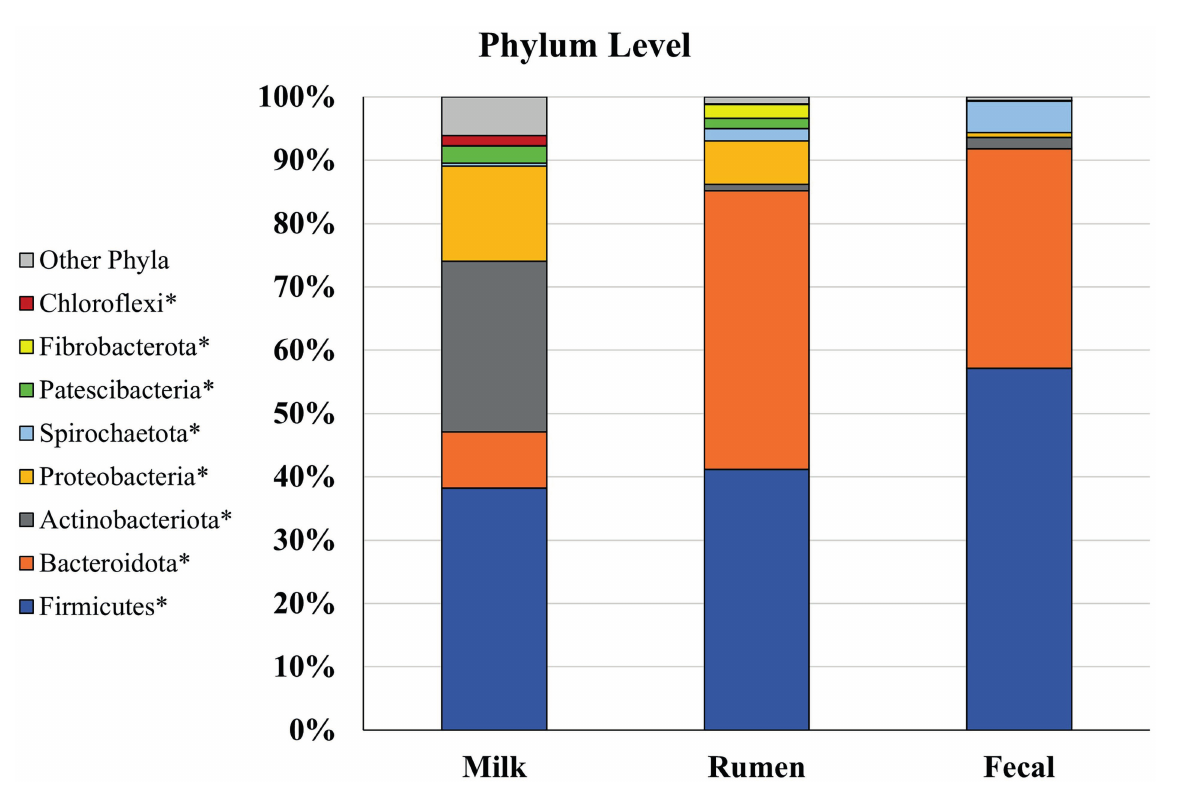
FIGURE 4 Relative bacterial abundance at the phylum level for Holstein dairy cattle in rumen ( n = 51), fecal ( n = 51), and milk samples ( n = 47): phyla with relative abundance ≥ 1% in one of the sample groups. *Samples within a phylum differ ( p ≤ 0.05) according to Bonferroni’s multiple